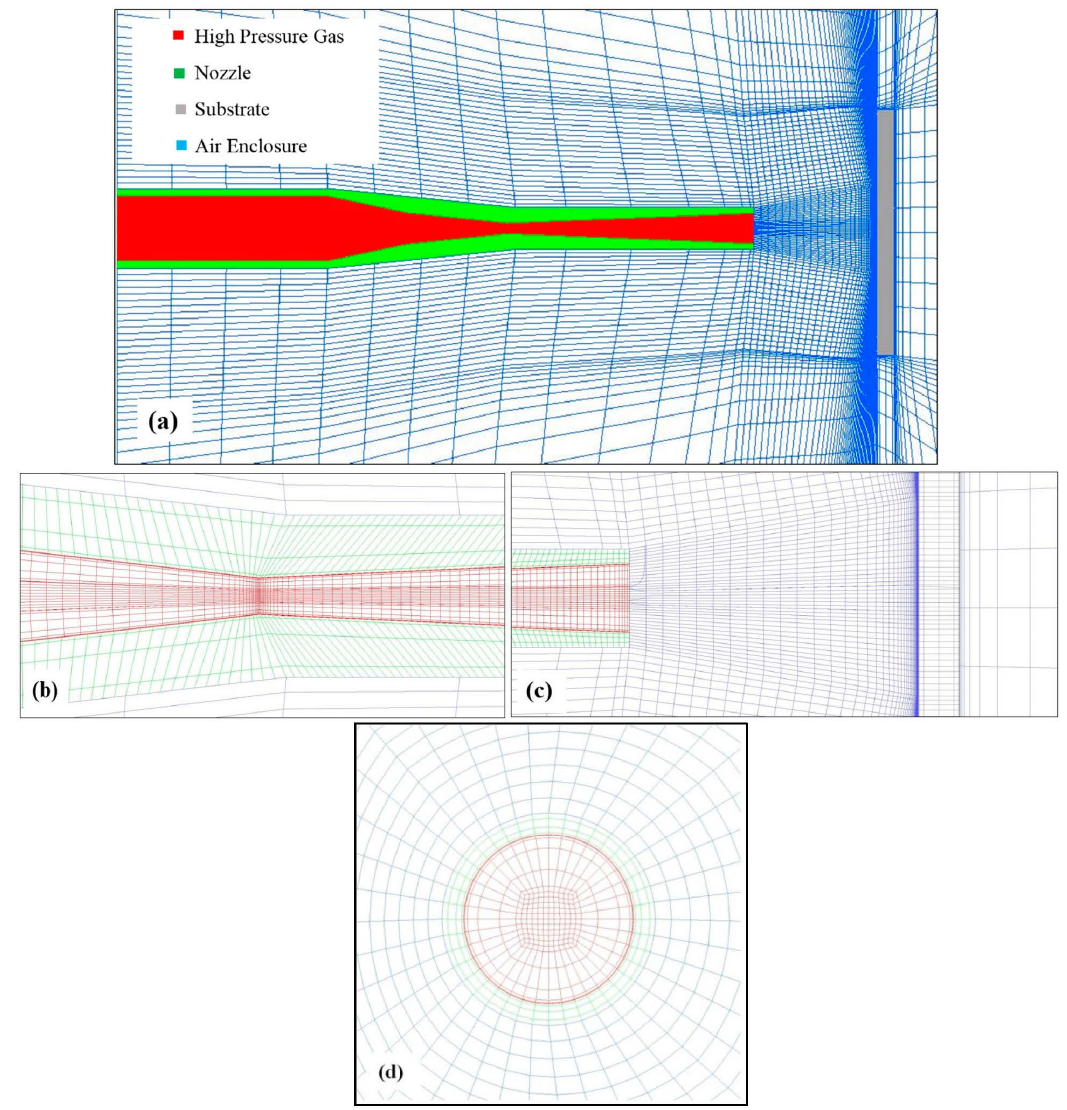
Figure 3. Developed mesh for solid and fluid domains ( a ) complete CFD three